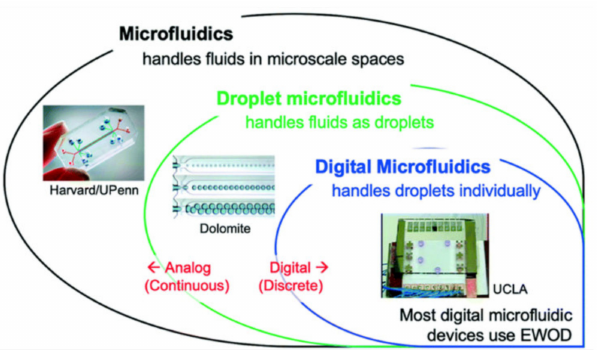
Figure 1. A road to analogue microfluidics to digital microfluidics. Image is adapted from ref. [25] with permission from the Royal Society of